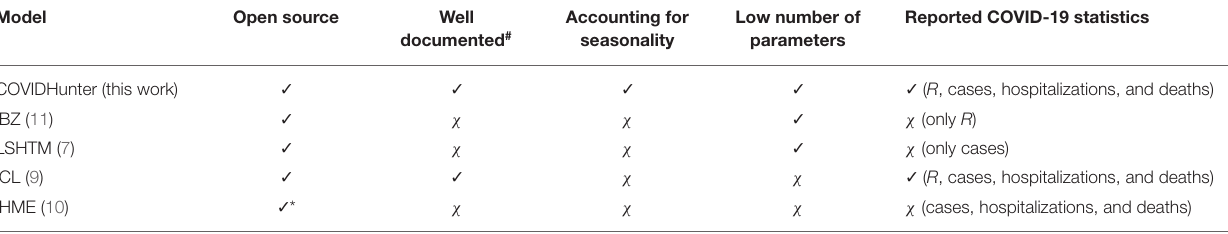
TABLE 1 | Comparison to other models used to inform government policymakers, as of January 2021.